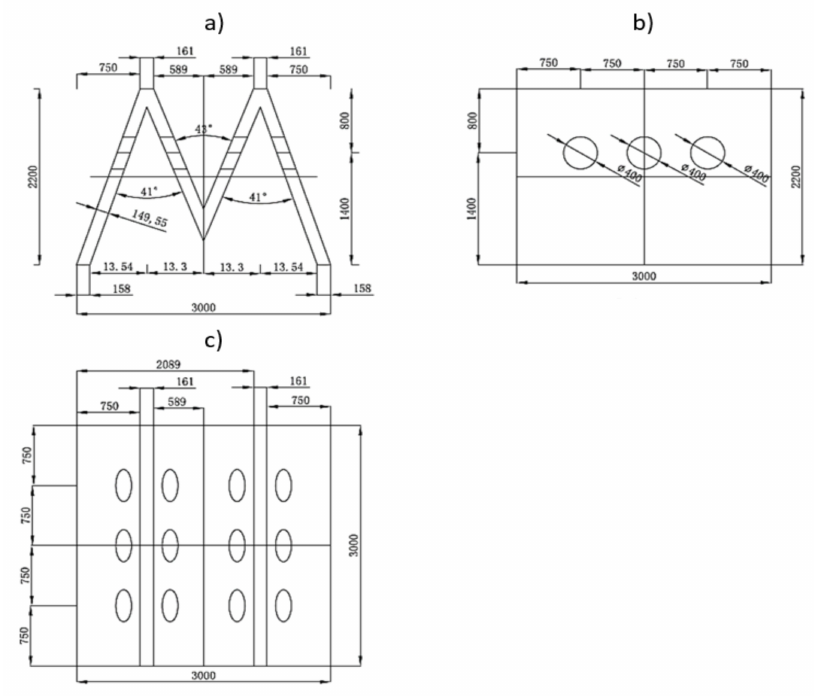
Figure 1. ( a ) Lateral, ( b ) side and ( c ) aerial views of the artificial reef prototype tested (all dimensions in